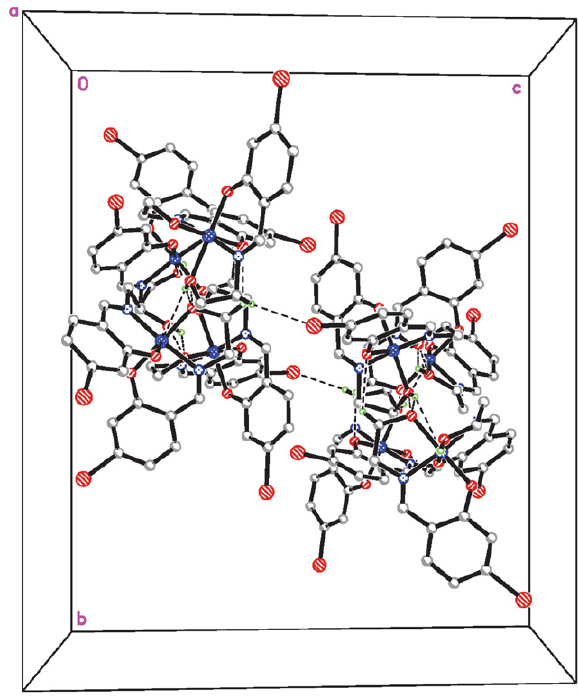
Fig. 8. Molecular packing structure of complex 4